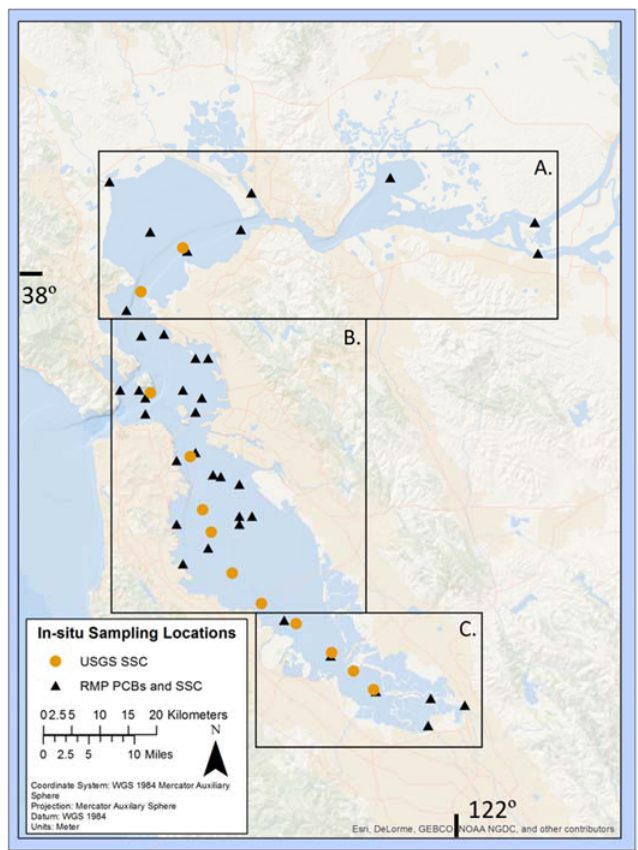
Figure 1. San Francisco Bay sampling locations; 1998–2006 PCB/SSC, 2016 SSC/reflectance. Boxes indicate the following sub-embayments: A. Northern Bay (San Pablo and Suisun Bays); B. South-Central Bay; and C. Southern Bay. Orange circles indicate USGS sampling locations (SSC, 2016, locations matched with reflectance obtained from satellite imagery), black triangles indicate SFEI Regional Monitoring Program sampling locations (PCBs and SSC, 1998–2006, in situ sampling).